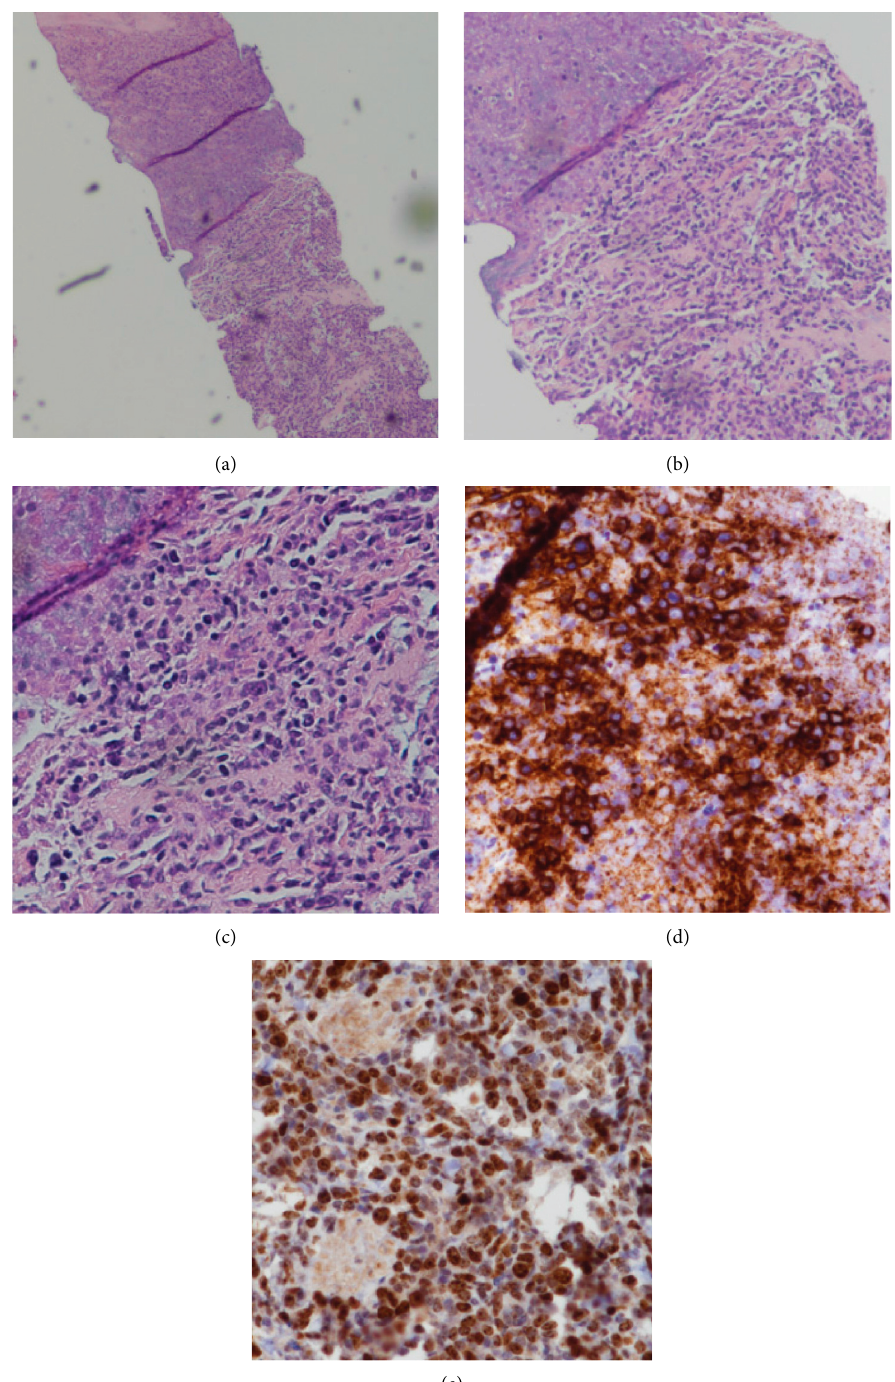
Figure 4: FNA and core biopsy of adrenal gland mass. H and E stain showing infiltration of large round blue cells and necrosis at 40x (a), 100x (b), 400x (c). CD20 stain highlight the infiltration of large round blue cells at 100x (d). Ki-67 stain showing a proliferation rate of > 90% of the infiltration of large round blue cells at 100x